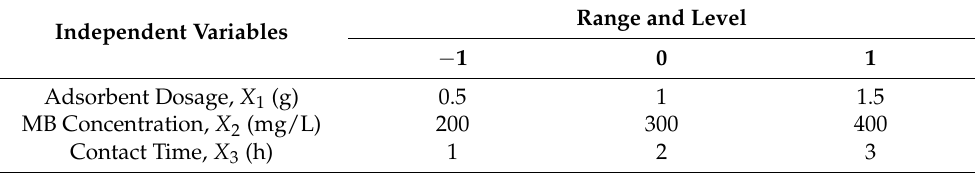
Table 3. Experimental ranges and levels of independent variables.